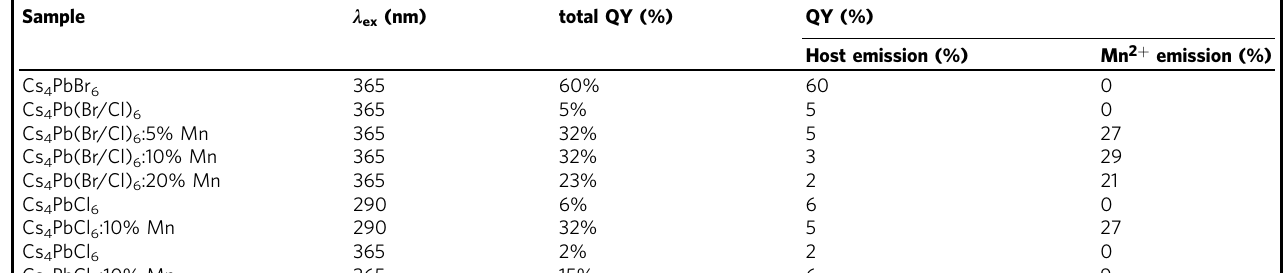
Table 2 PL quantum yield of the Cs 4 PbX 6 colloids in n-octane medium Sample